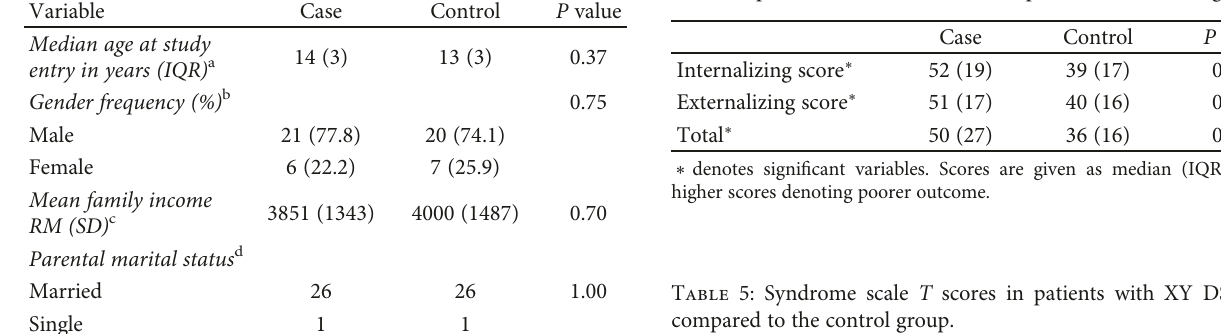
Table 4: Total, internalizing, and externalizing T scores from the CBCL in patients with XY DSD as compared to the control group.